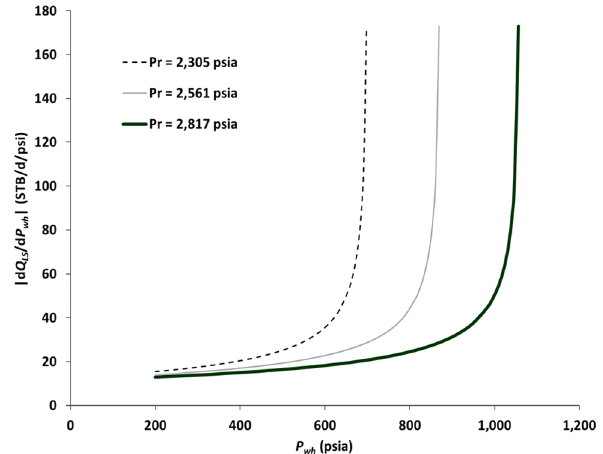
Fig. 13 Stability plots for well A at 30% water cut, but different res‑ ervoir